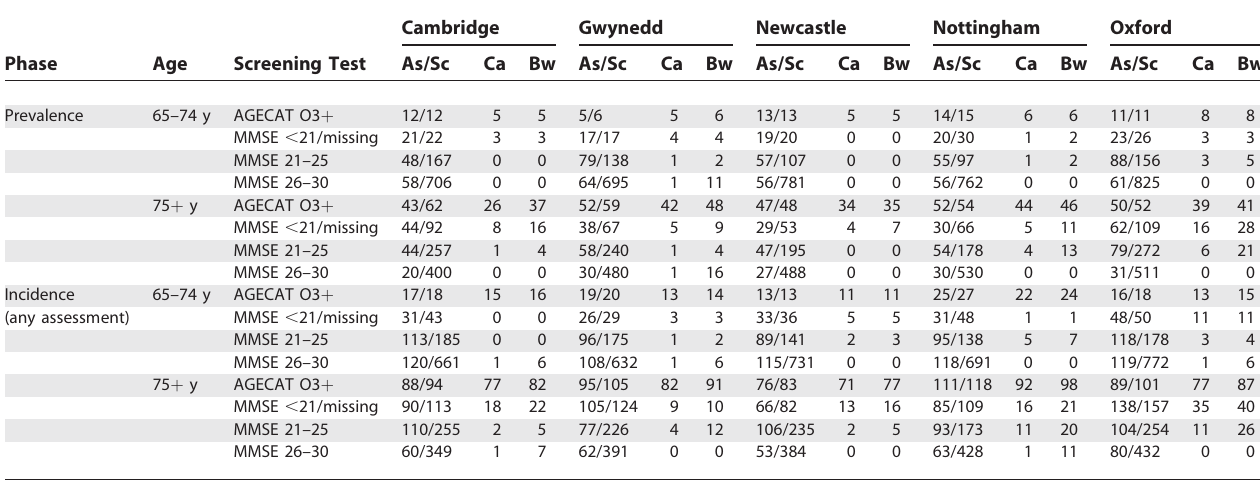
Table 2. Numbers Assessed, Screened, Number of Actual Cases, and Back-Weighted Cases to Total Population by Sampling Strategy and Centre–Only Individuals Seen at Both Prevalence and Incidence